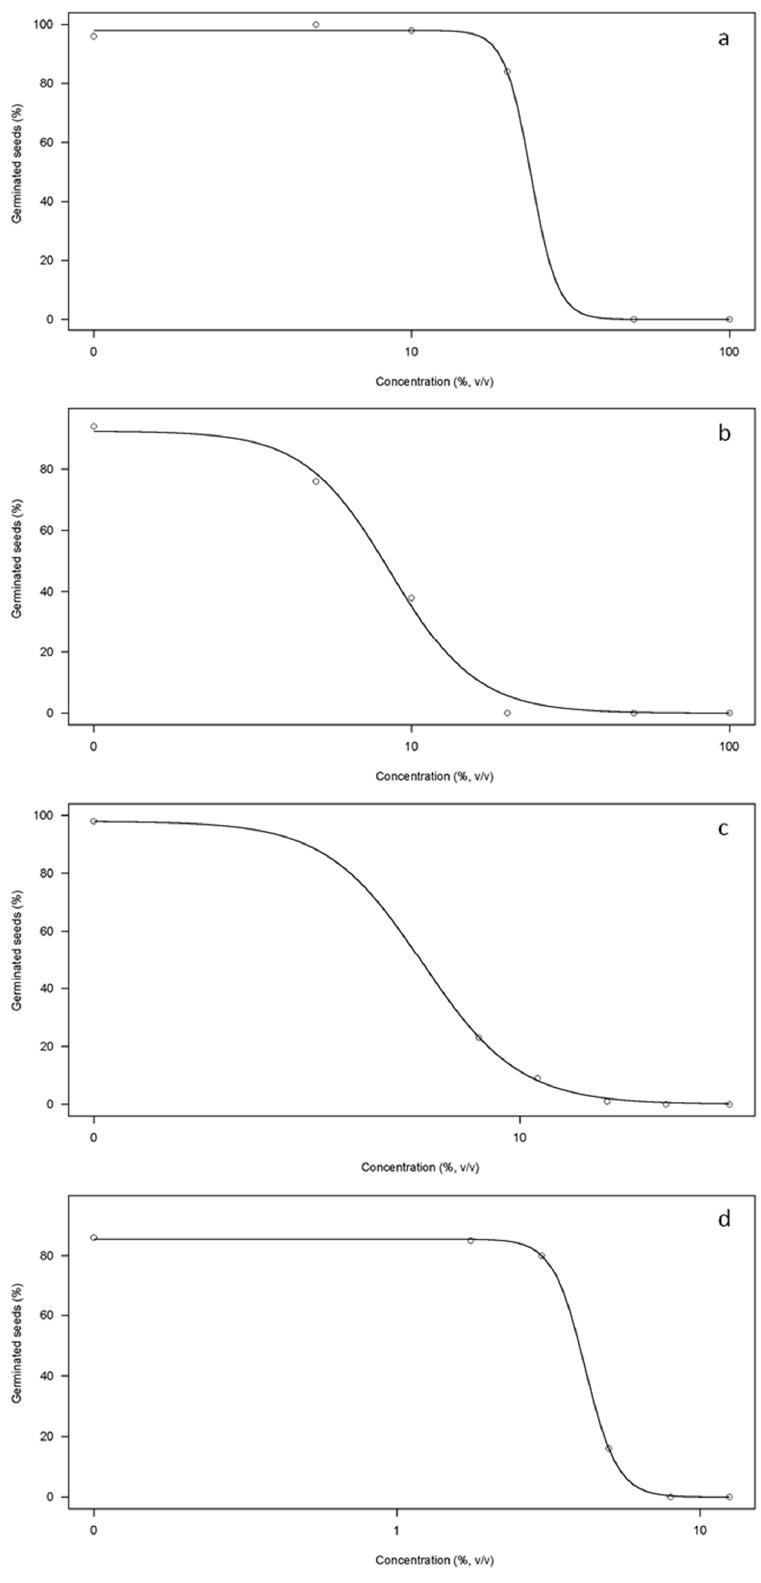
Figure 6. Proportion of germinated seeds for the different concentrations of concentrated products applied: ( a ) barley seeds and PS-concentrate, ( b ) rapeseed and PS-concentrate, ( c ) barley seeds and D-concentrate and ( d ) rapeseed and D-concentrate. The concentrations applied for barley were 0; 8.0; 11.0; 16.0; 22.0; 31.0% ( v / v ), whereas for the rapeseed they were 1.75; 3.0; 5.0; 8.0; 12.5% ( v / v